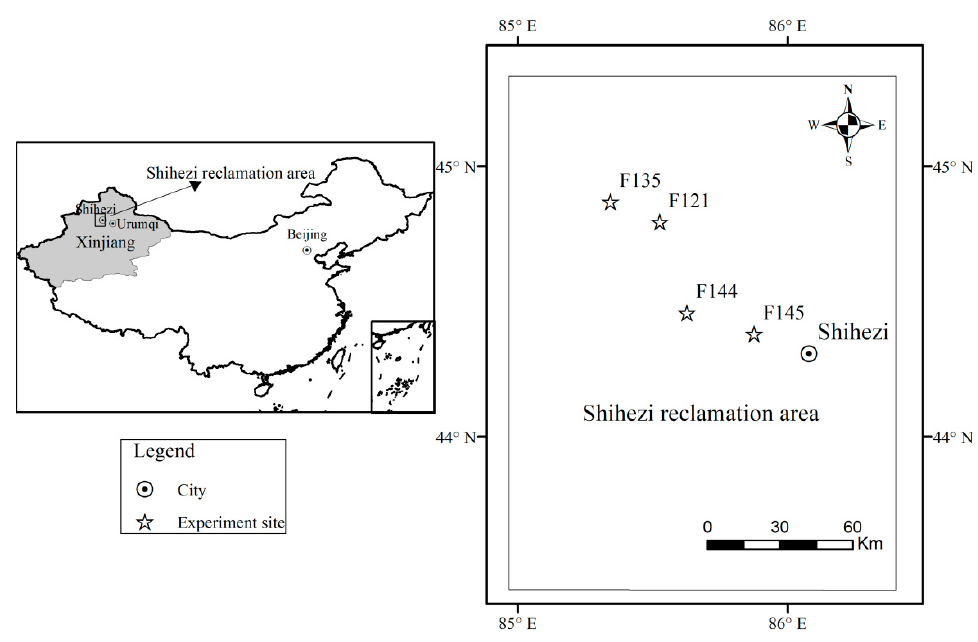
Figure 1. Location map of experimental sites in Shihezi reclamation area, Xinjiang, China.